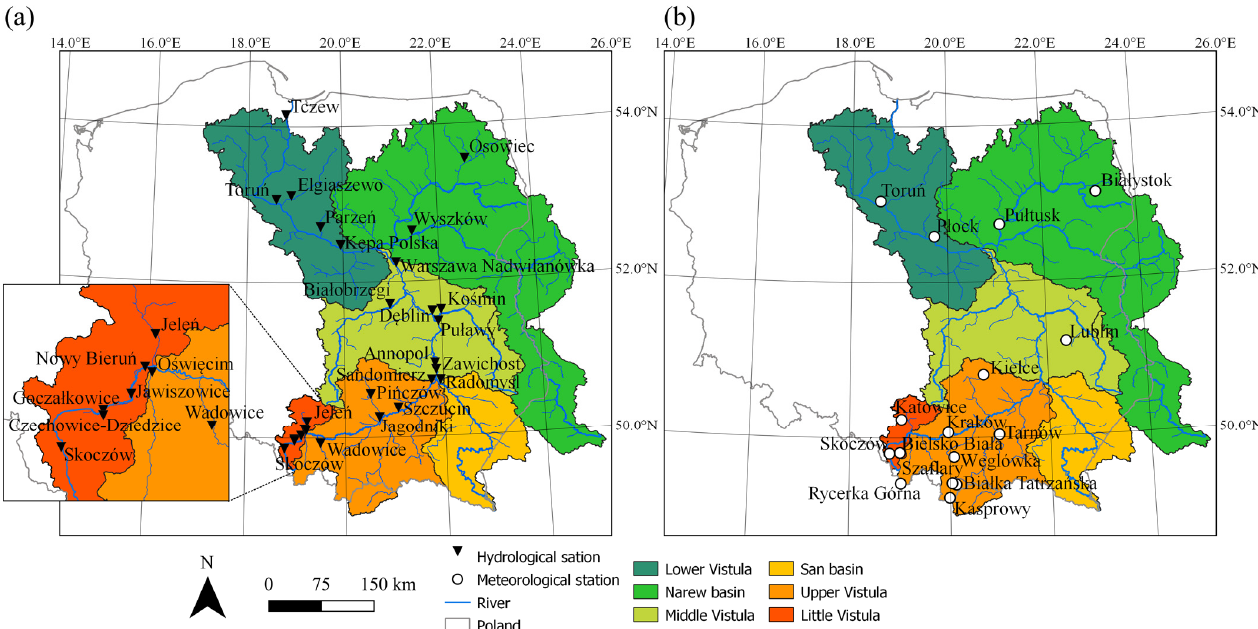
Figure 1. The hydrographic division of the Vistula basin with the hydrological ( a ) and precipitation ( b ) stations used in the study.